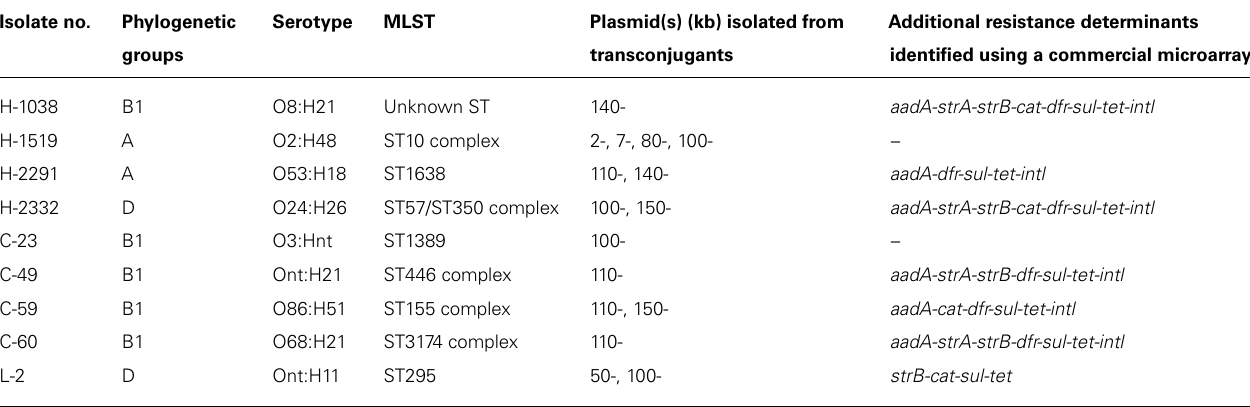
Table 1 | Summary of genotypic and phenotypic characteristics of nine ESBL-producing E. coli isolates cultured from healthy food-producing animals and humans in Switzerland. Isolate